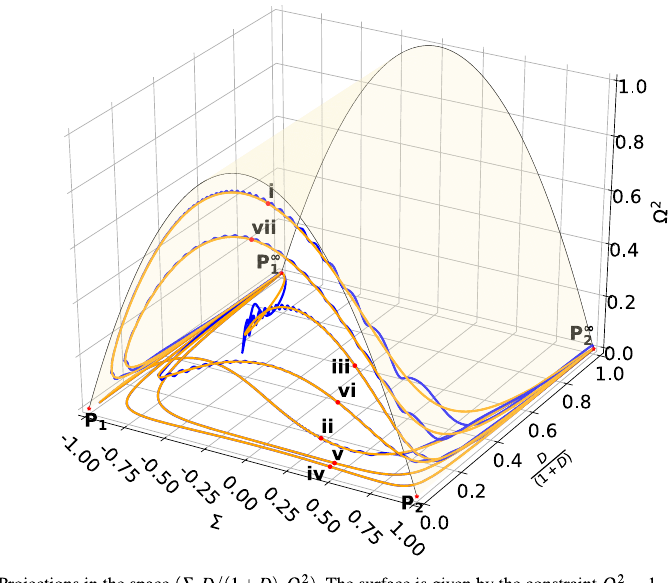
Fig. 17 Some solutions of the full system (93) (blue) and time-averaged system (127) (orange) for the KS metric when γ = 4 in the projection Q = 3